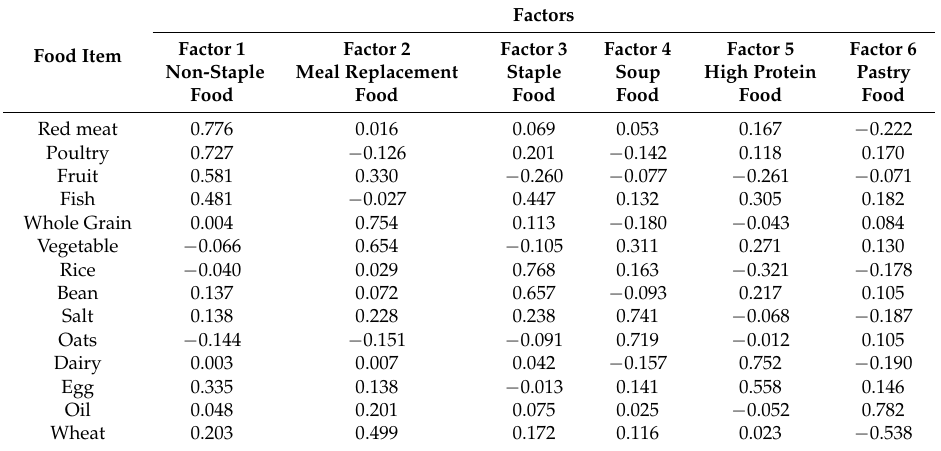
Table 3. Rotated coefficients for a 6-factor solution using principal component analysis and varimax